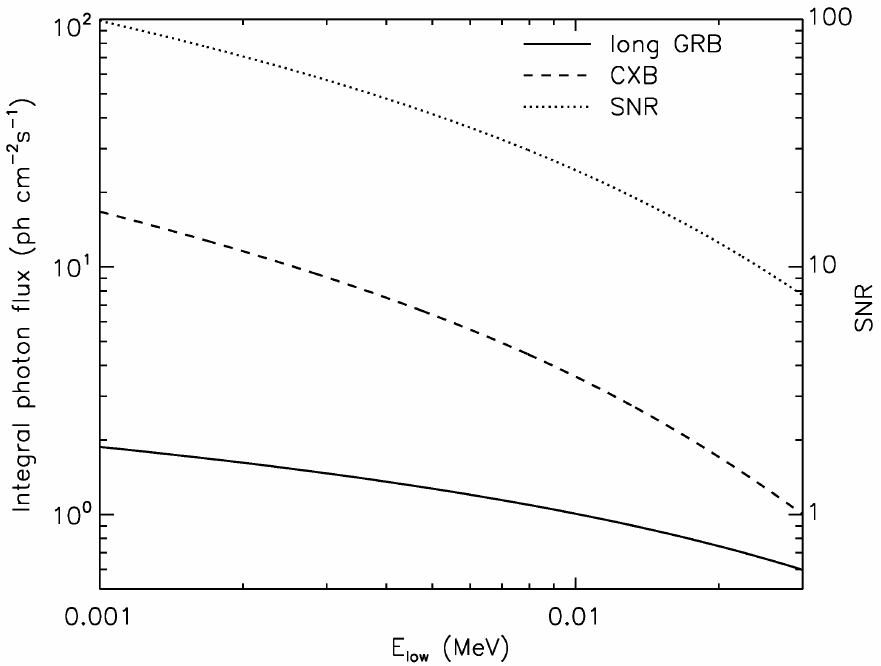
Figure 9. Integral photon flux of typical long GRB (fluence spectrum) and CXB as a function of the low-energy threshold, with E high fixed to 200 keV. The right-hand y-axis shows the SNR value of the UBAT assuming a photon collection time of 1 s.